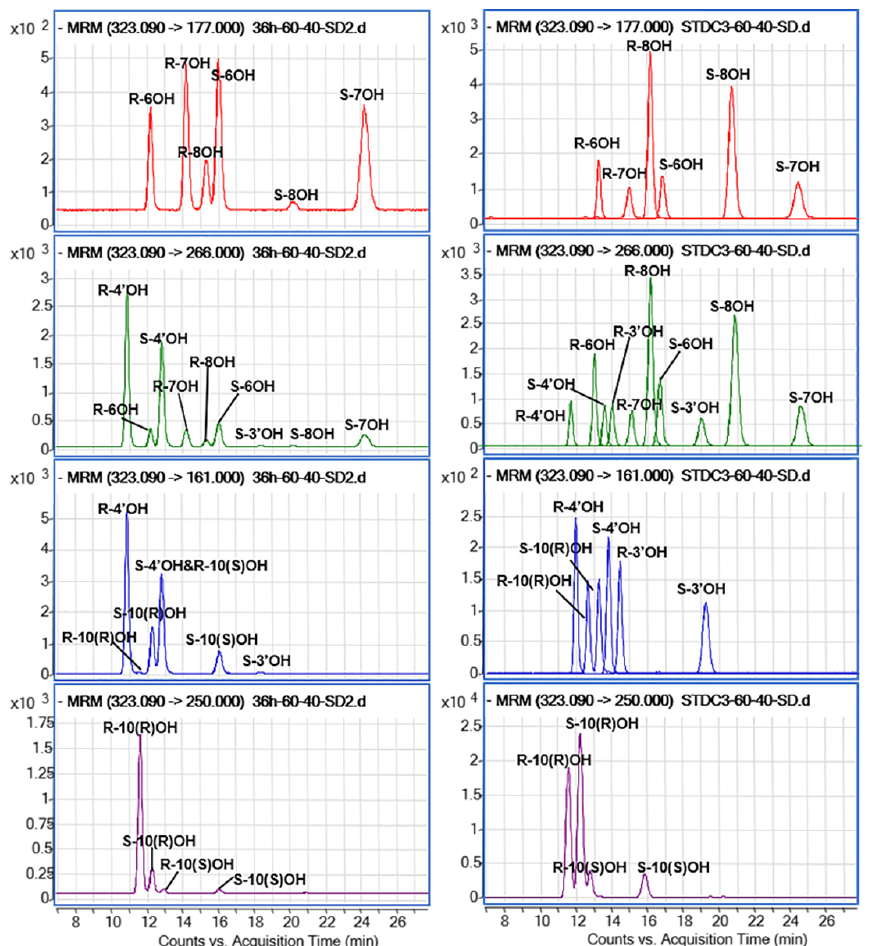
Figure 3. Characterization of warfarin hydroxylation metabolites in rat plasma. The targeted multiple reaction monitoring channels chromatograms of hydroxy-warfarin in plasma samples ( left pane) and standard samples ( right pane).